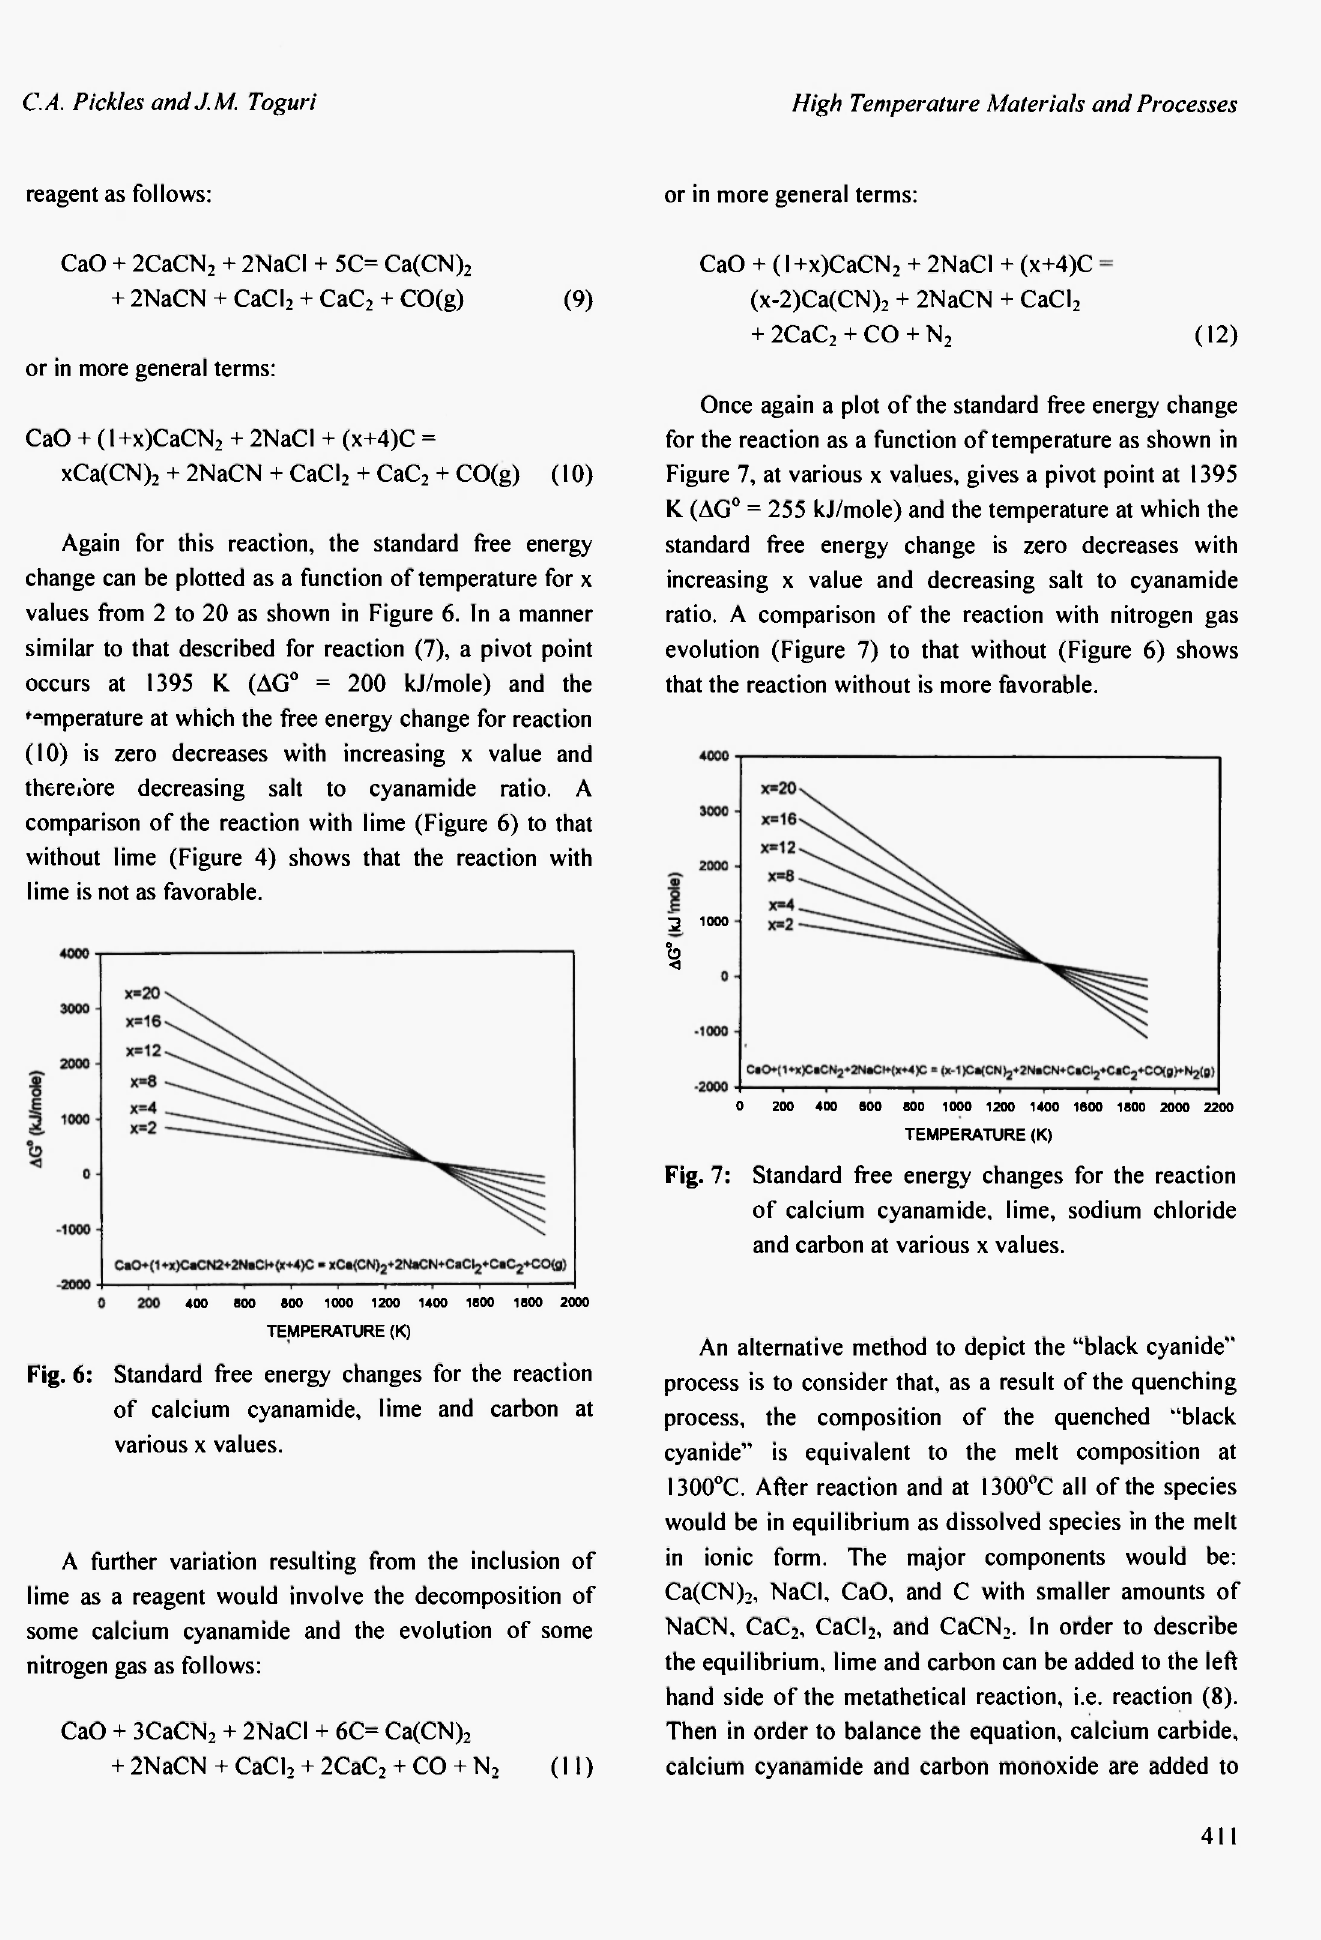
Fig. 7: Standard free energy changes for the reaction of calcium cyanamide, lime, sodium chloride and carbon at various χ